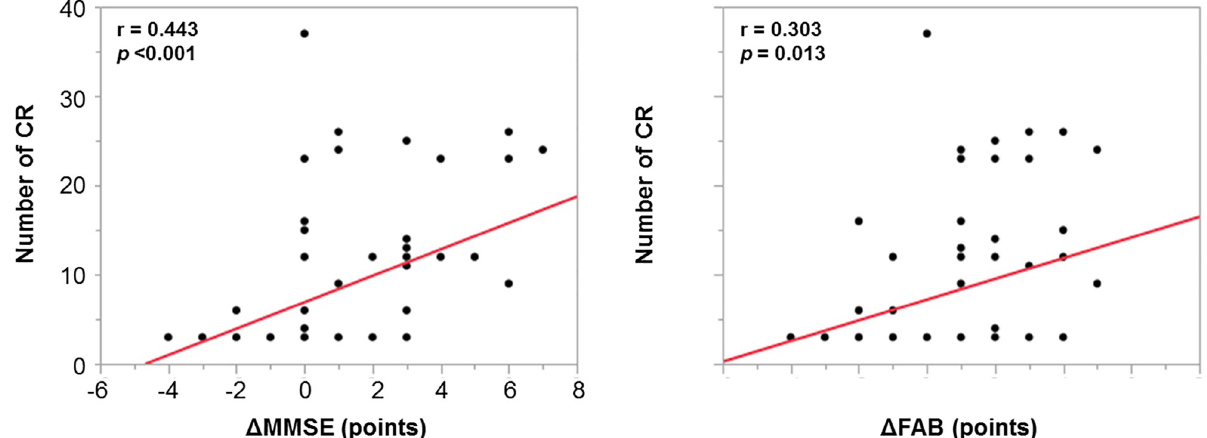
Fig 4. Correlation between the number of CR and change in cognitive function. A significant linear correlation was observed between the number of CR and the change in cognitive function assessed using MMSE and FAB. CR, cardiac rehabilitation; FAB, Frontal Assessment Battery; MMSE, Mini- mental State Examination.